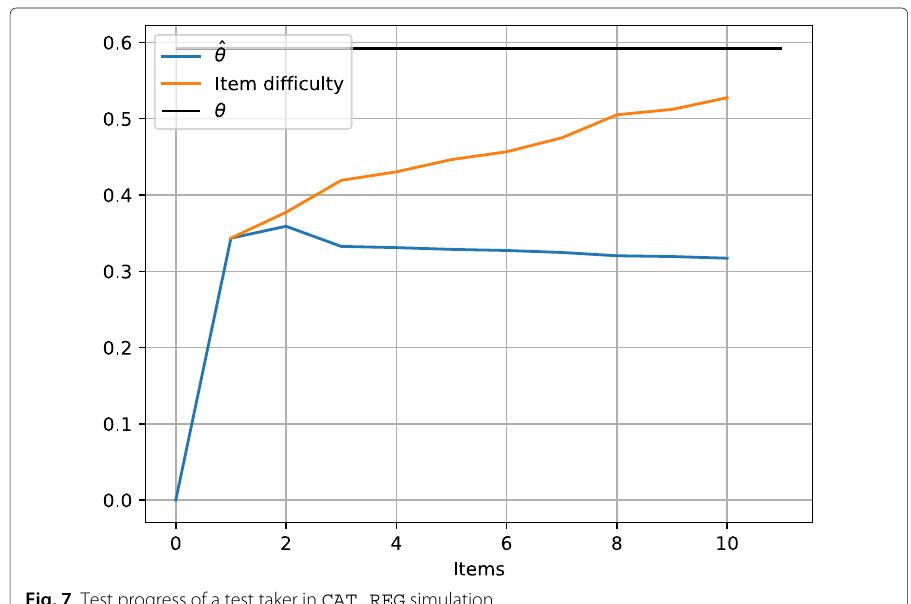
Fig. 7 Test progress of a test taker in CAT_REG simulation